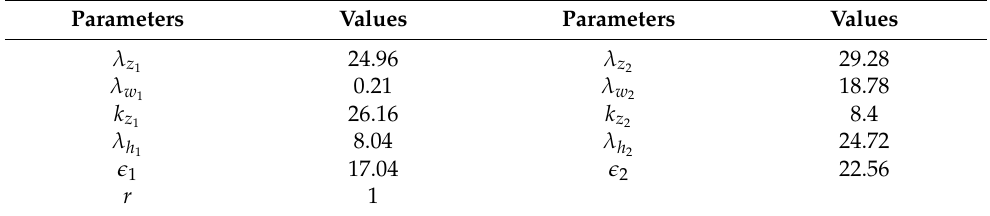
Table 1. Control parameters.